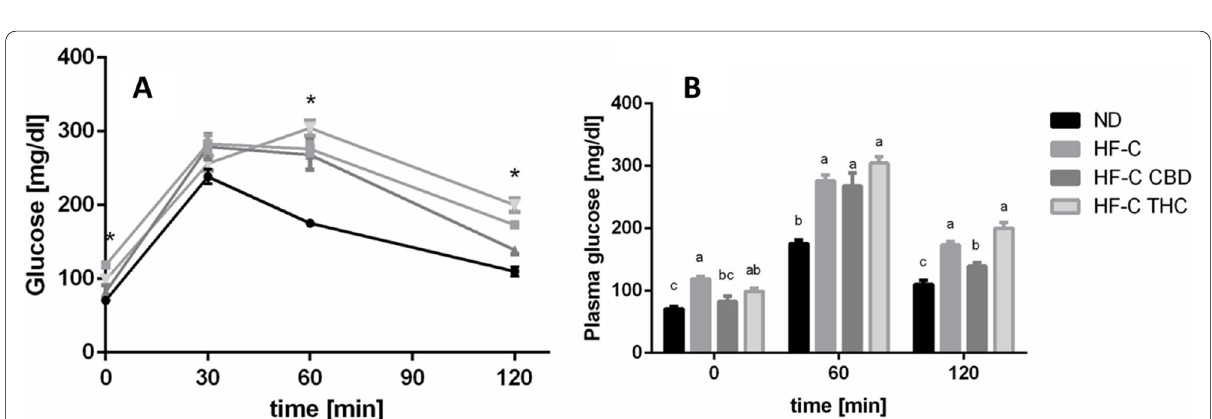
Fig. 4 Effect of THC or CBD treatment on glucose tolerance levels in mice fed HFCD. Male C57BL/6J mice aged 7–8 weeks were fed either normal diet (ND, n 8), high fat 1%(w/w) cholesterol 0.5%(w/w) cholate diet (HF‑C, n = + + HFCD containing THC (2.5 mg/kg) (HF‑C THC, n 8). After 5 weeks, oral glucose test tolerance was performed with values presented as =